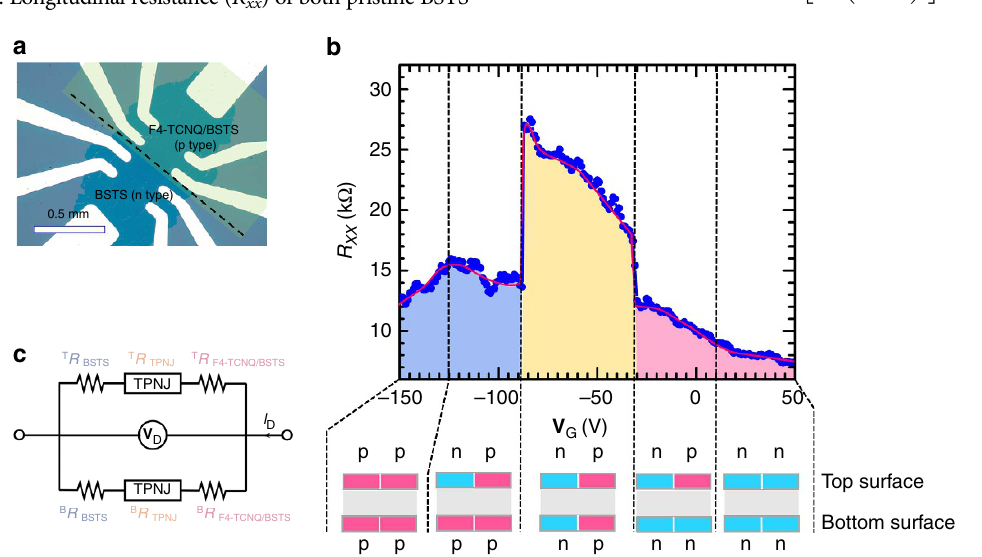
Figure 2 | Electric transport of TPNJ device. ( a ) Microscope view of a TPNJ device. BSTS thin film with 10nm thickness grown on mica was transferred on a SiO 2 /Si substrate to fabricate a bottom gate field effect transistor. F4-TCNQ was partly deposited on the BSTS thin film to realize injection of holes on the partial area of BSTS. ( b ) Gate voltage ( V G ) dependence of R xx across the TPNJ made between pristine BSTS and F4-TCNQ/BSTS at 2K. Schematic views of the TPNJ for the top and the bottom surface states available from the present device are illustrated. ( c ) The equivalent electric circuit of the present device. The electronic circuit of TPNJ involving both top and bottom surfaces can be described as a parallel circuit connection of resistance. NATURE COMMUNICATIONS|7:13763|DOI: